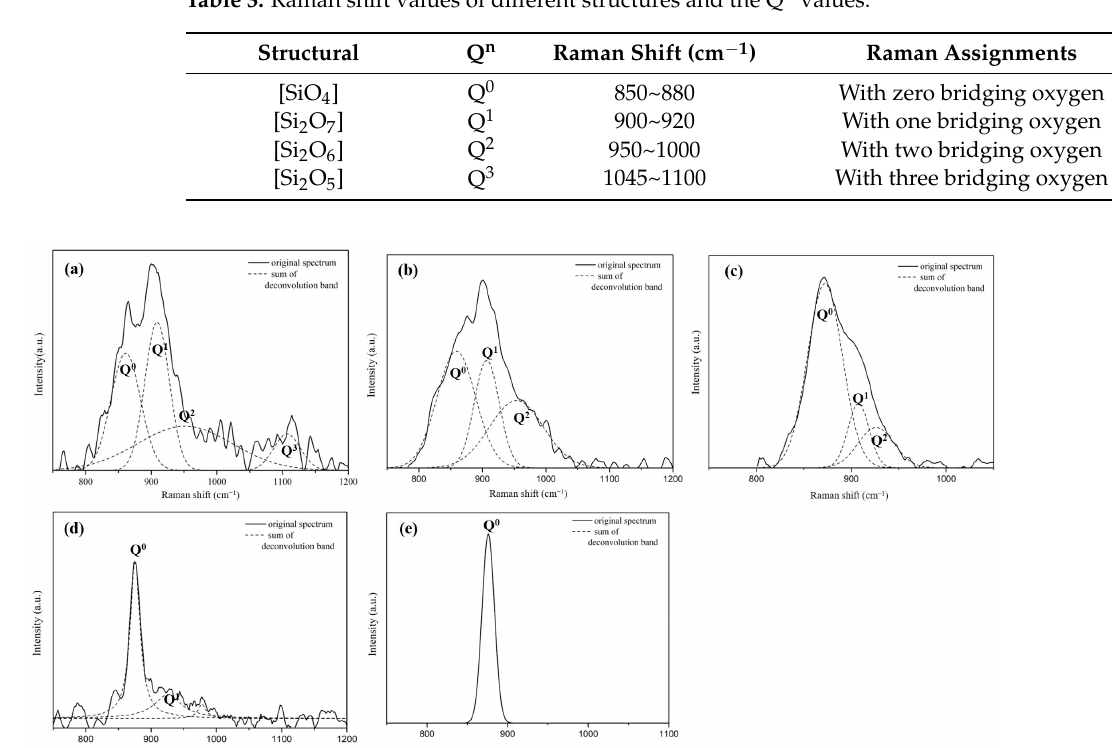
Figure 7. Analysis of the Raman spectral profiles and different Q n Raman shift values of each sample of slags, the MgO content is ( a )5.7wt.%, ( b ) 7.4wt.%, ( c ) 9.6wt.%, ( d ) 11.5wt.%, ( e ) 13.6wt.%.